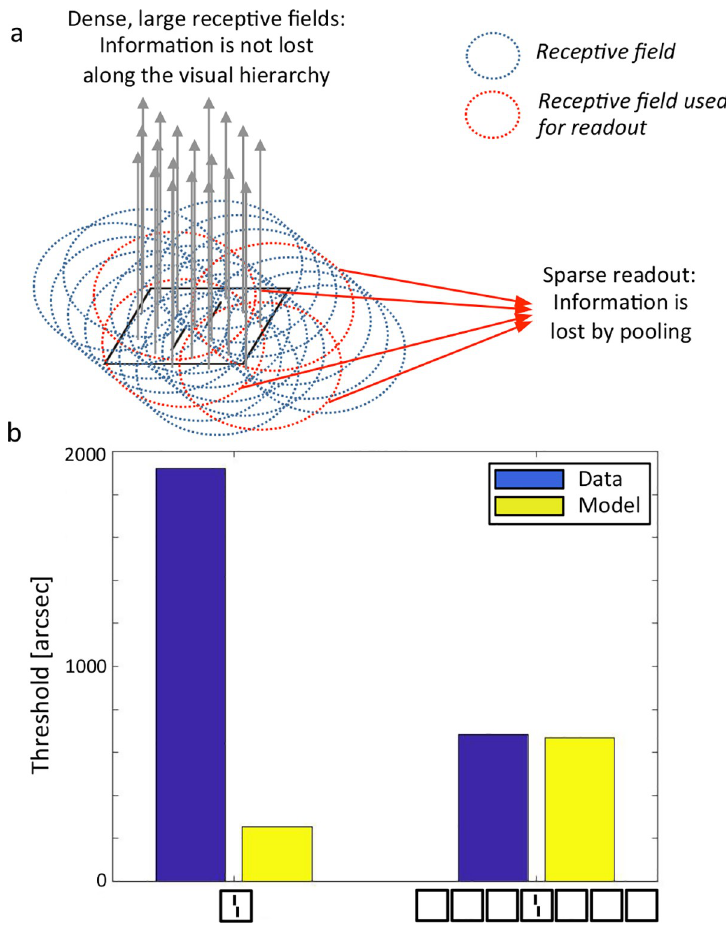
Fig 12. Hierarchical Sparse Selection model. a. The model posits that receptive fields along the visual hierarchy are large and dense. This allows for “lossless” transmission of information through the visual system. For instance, the offset of the vernier in this illustration is not corrupted by pooling thanks to the density of the receptive fields (blue and red circles). Crowding occurs because, when we try to access information, only a few sparse receptive fields are used for readout (red circles). Hence, crowding occurs at readout because of sparse sampling of receptive fields. This sparse readout can occur at any stage of visual processing, from low-level features (shown here) to faces. b. Uncrowding does not occur in the Hierarchical Sparse Selection model because performance is worse for the model on the 7 squares than the 1 square condition, contrary to human performance. NB. This model only produces a scalar output, there is no output